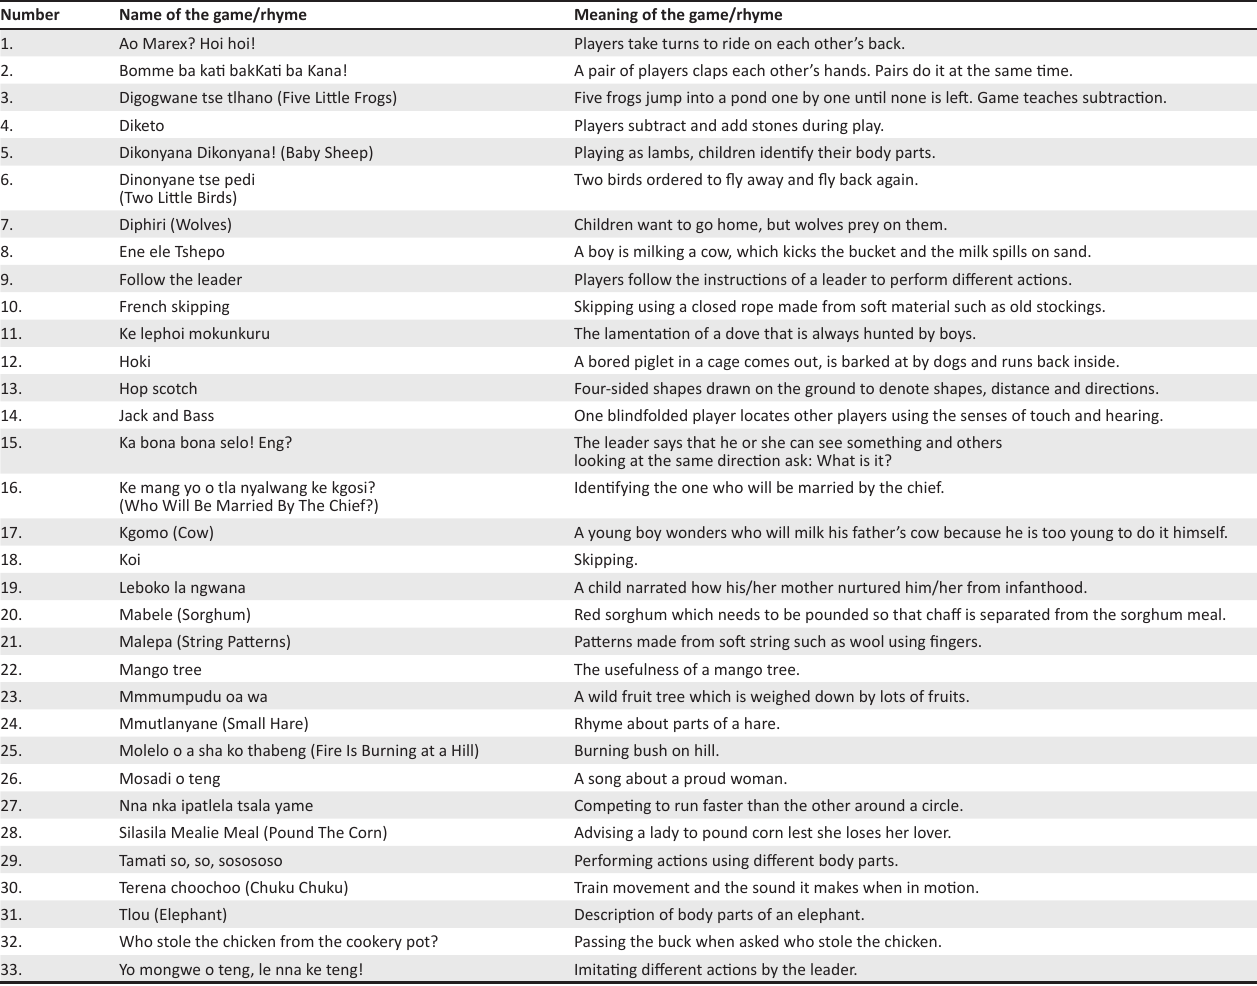
TABLE 1: List of games and their meanings. Number Name of the game/rhyme Meaning of the game/rhyme